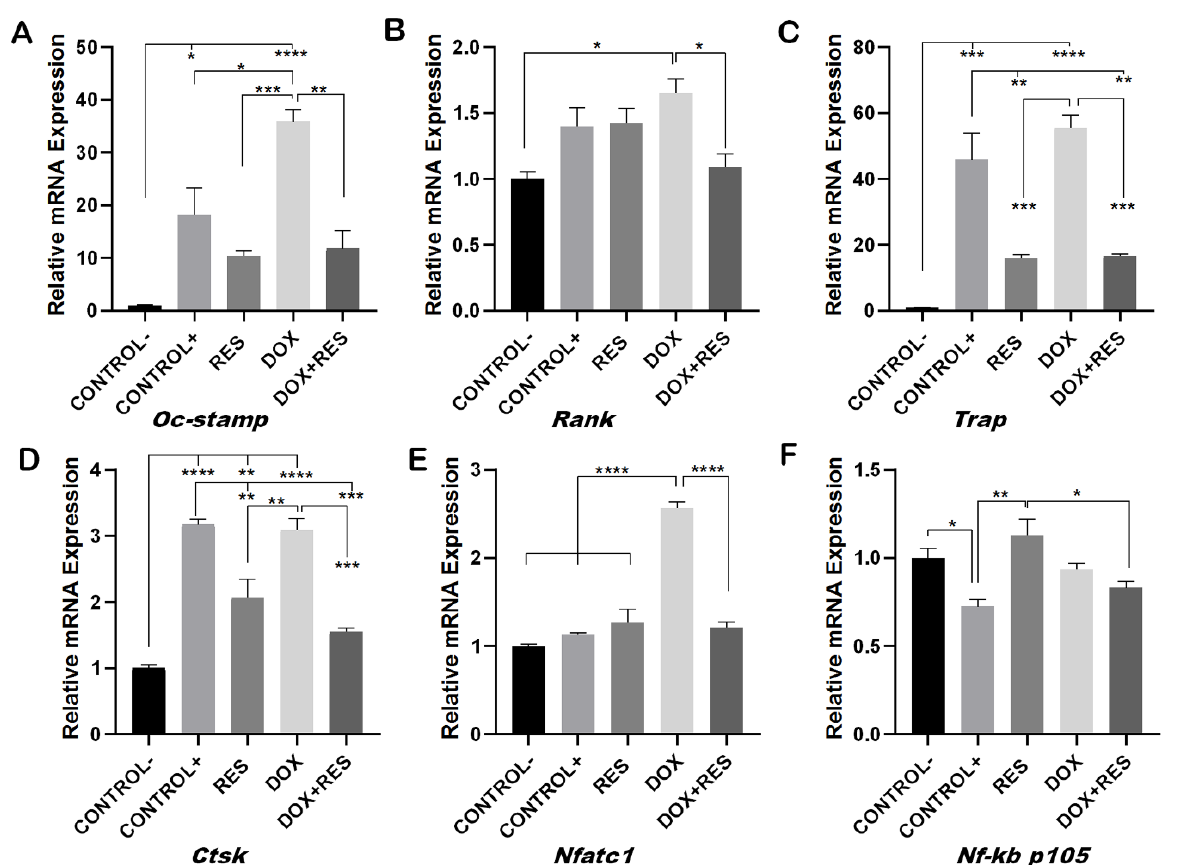
Figure 3. Inhibition of doxorubicin-induced osteoclast differentiation by resveratrol. RAW 264.7 cells were cultured for 4 days with M-CSF (30 ng/mL) and RANKL (50 ng/mL) and treated with resveratrol (RES) and doxorubicin (DOX) alone or combined. Levels of mRNA expression for Oc-stamp ( A ), Rank ( B ) Trap ( C ), Ctsk ( D ), Nfatc1 ( E ) and Nf-kb p105 ( F ) were analyzed by qPCR. One-way ANOVA, Tukey’s multiple comparisons test, *— p ≤ 0.05, **— p ≤ 0.01, ***— p ≤ 0.001, ****— p ≤ 0.0001.